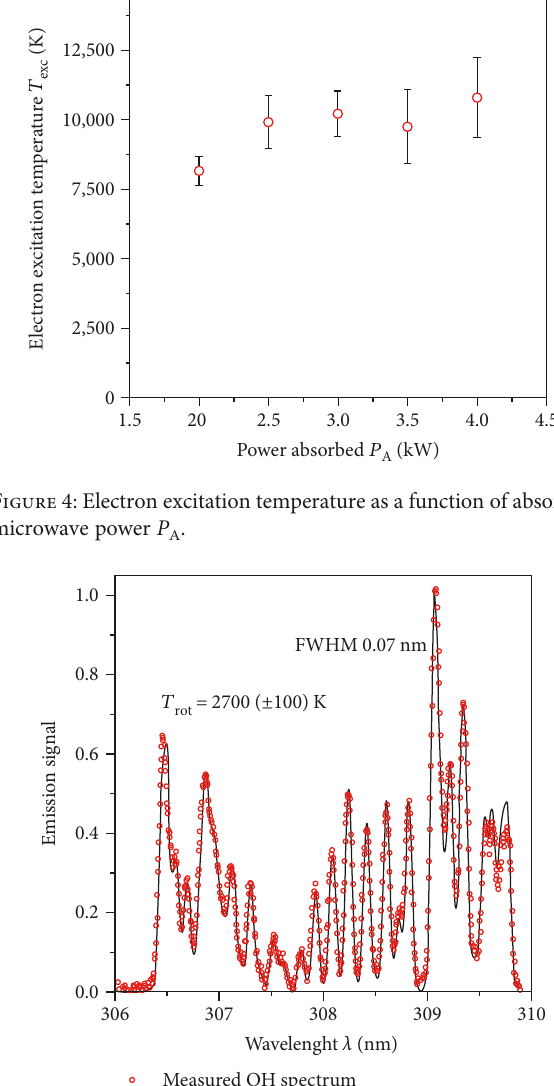
Figure 5: Comparison of the measured and simulated in LIFBASE emission spectra of OH band. Absorbed microwave power P =3kW and argon fl ow rate Q =50 l/min. A